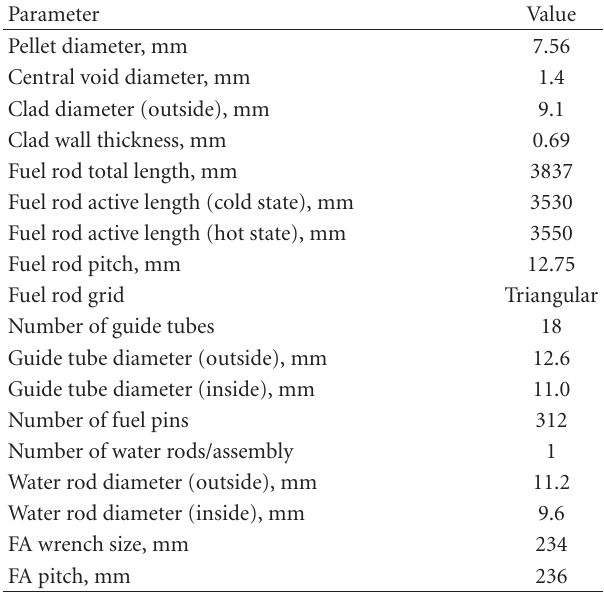
Table 1: Main parameter of the VVER-1000